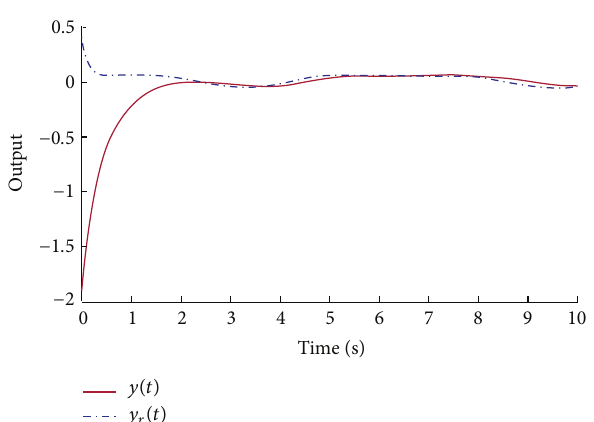
Figure 6: System output tracking trajectory with nonzero initial